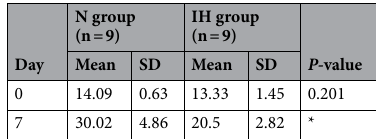
Table 1. Changes in body weight (g).